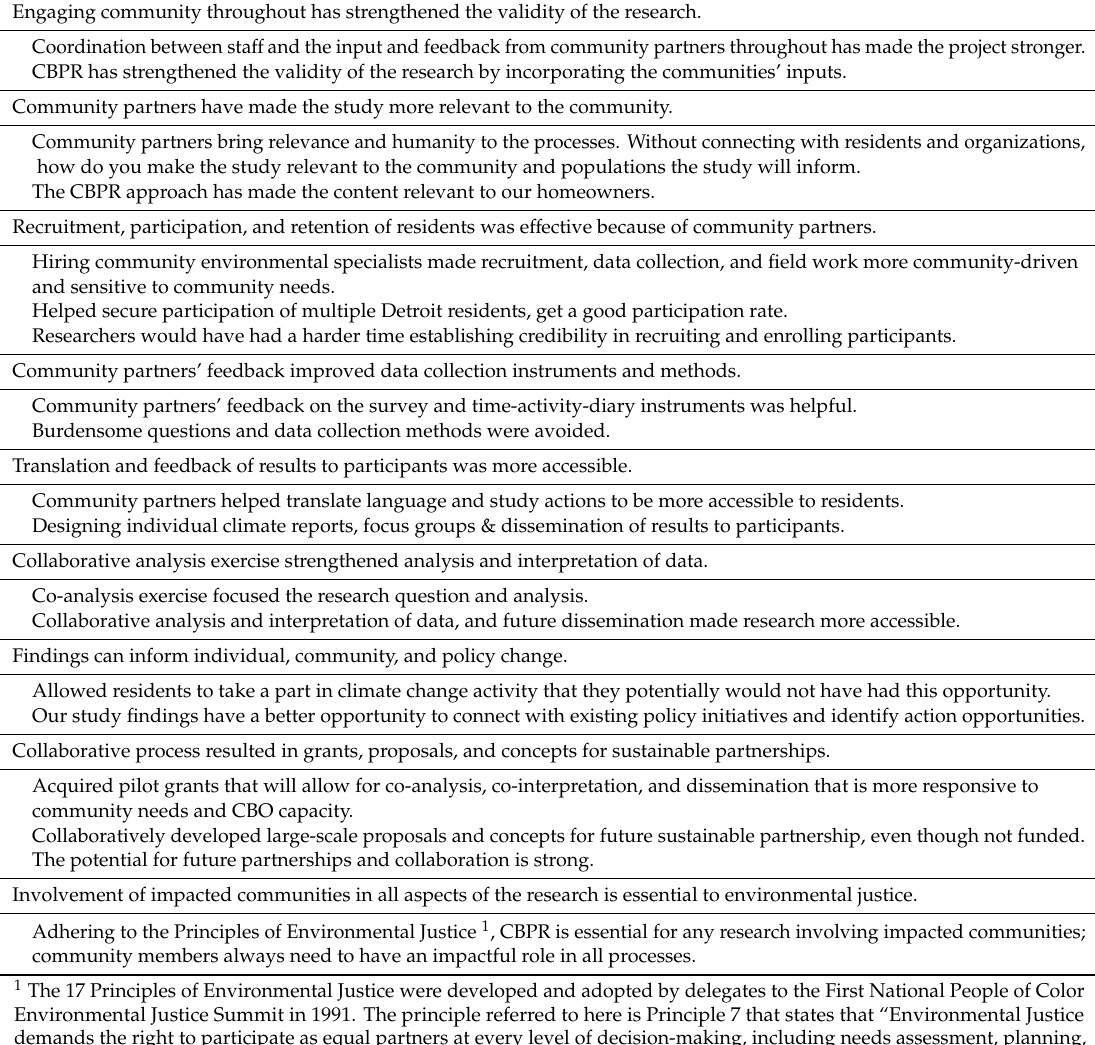
Table 3. How using CBPR strengthened the research: Emergent themes followed by examples of verbatim responses from partnership evaluation survey results, Years 1 and 2